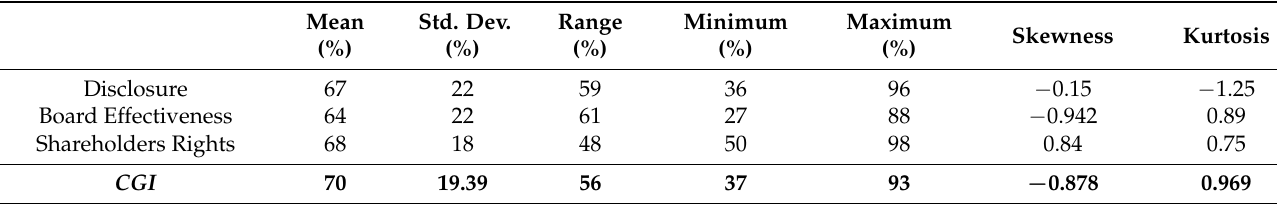
Table 1. Summary statistics for